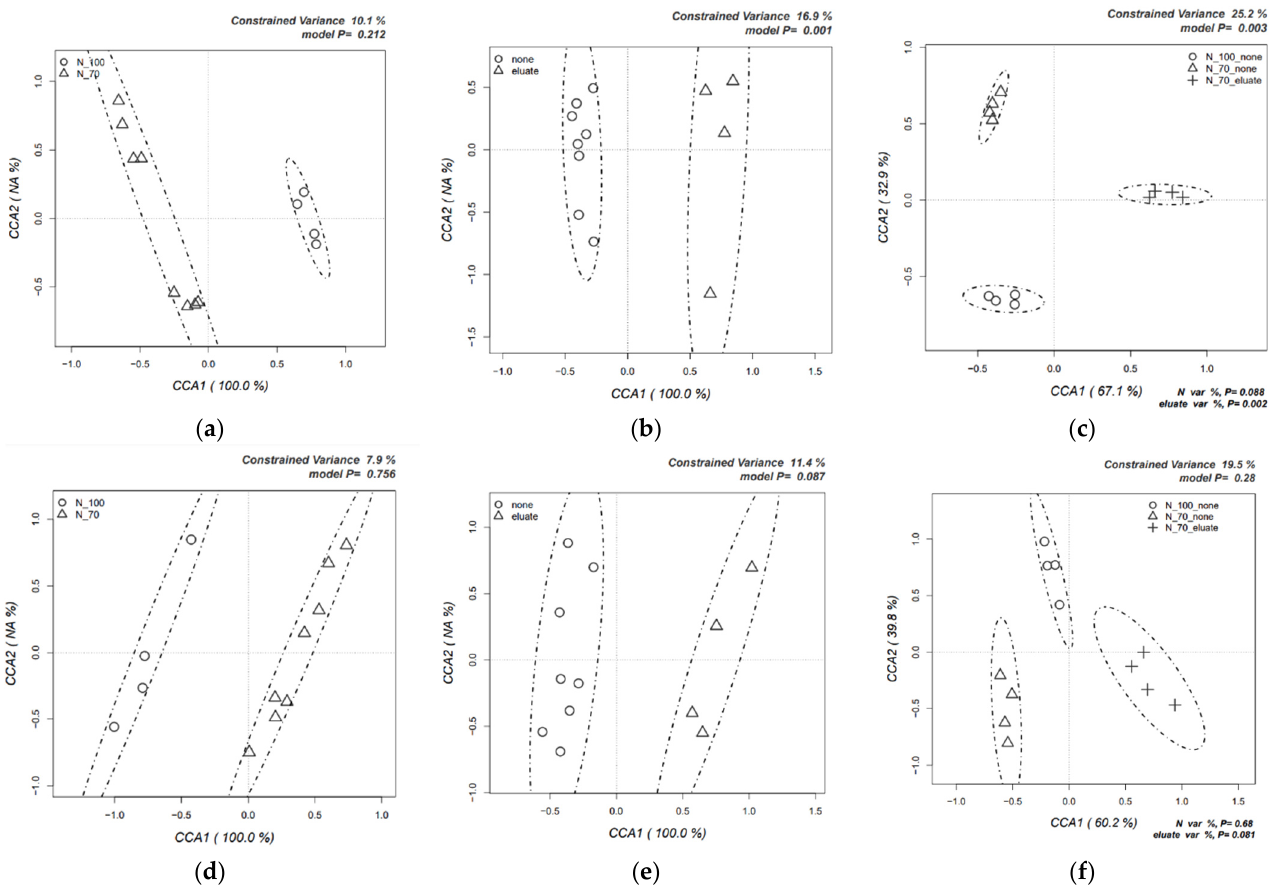
Figure 3. Canonical correspondence analyses (CCAs) on the impact of the eluate treatments at two levels of Nitrogen availability on the structure of bacterial communities. Dedicated p values are indicated on the right upper and left lower corners of the results (Upper half ( a , b , c ) is tomato. Lower half ( d , e , f ) is lettuce).